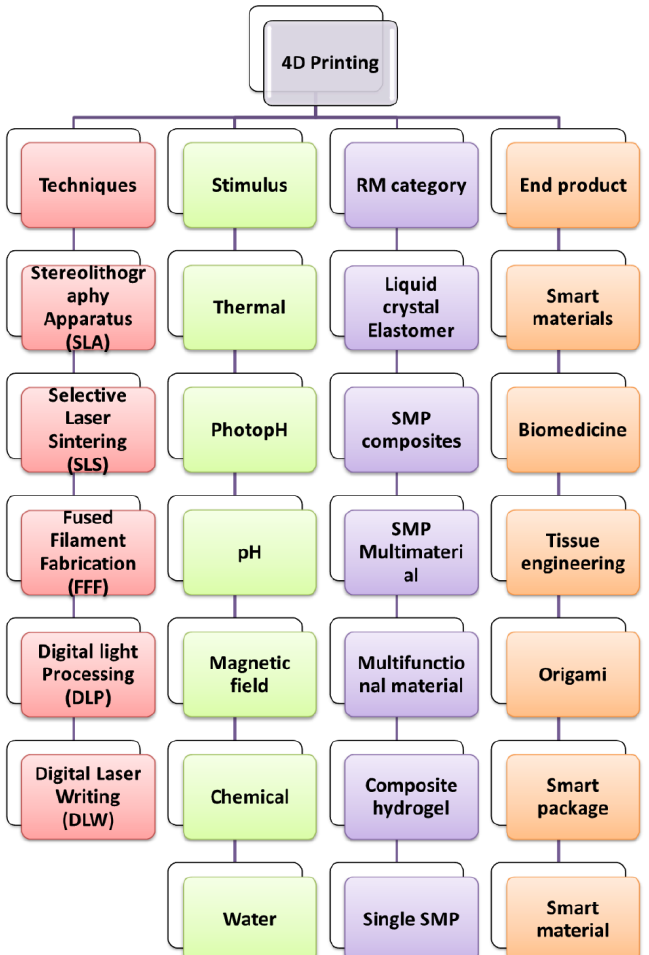
Figure 3. Application of 4D Printing in Healthcare which includes 4D printed organs, implants, tissue, etc.